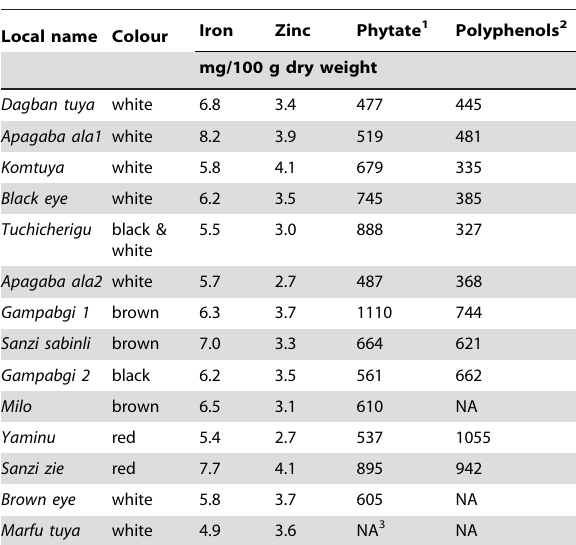
Table 2. Iron, zinc, phytate and polyphenol composition of landraces of cowpeas locally available in northern Ghana.